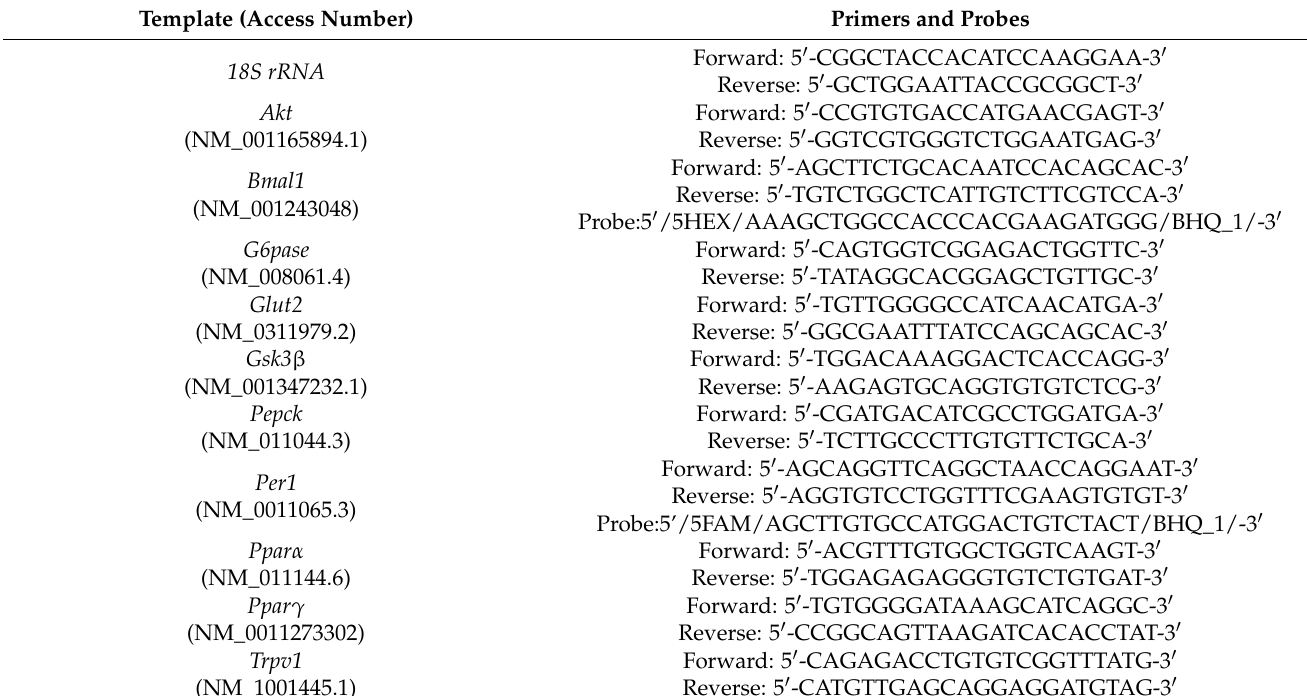
Table 3. Gene access numbers and sequences of primers and